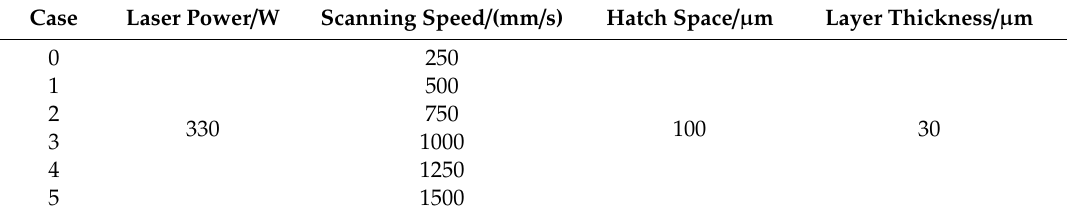
Table 3. Single-factor experiment of scanning